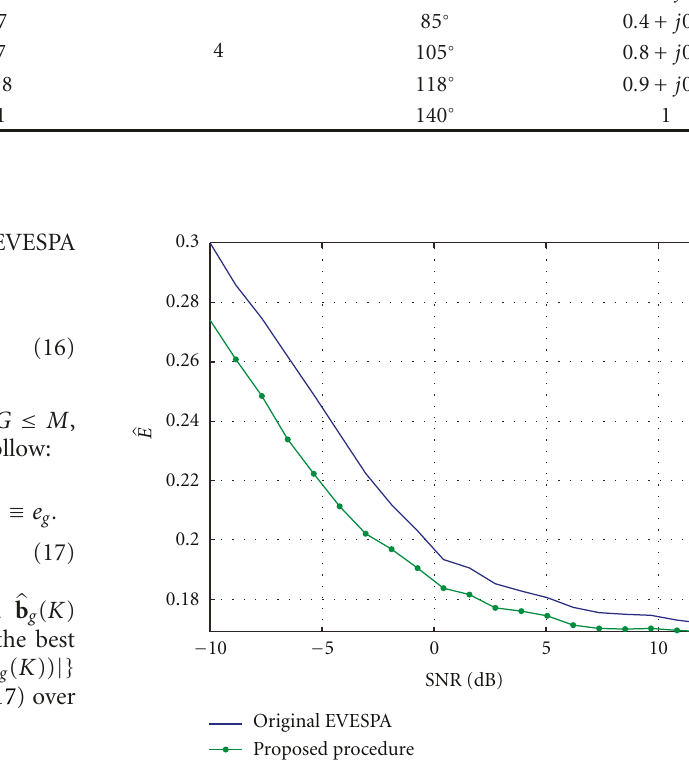
Figure 2: Statistical performance comparison between the original and the proposed estimation